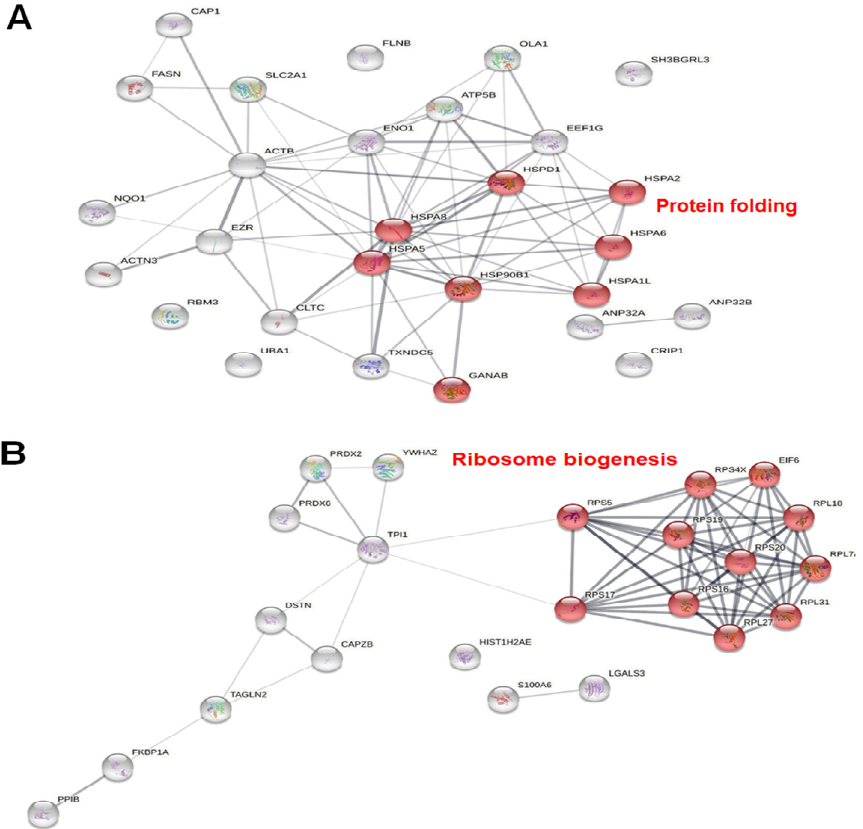
Figure 6. Protein–protein interaction networks for up-regulated ( A ) and down-regulated ( B ) proteins according to the STRING database .